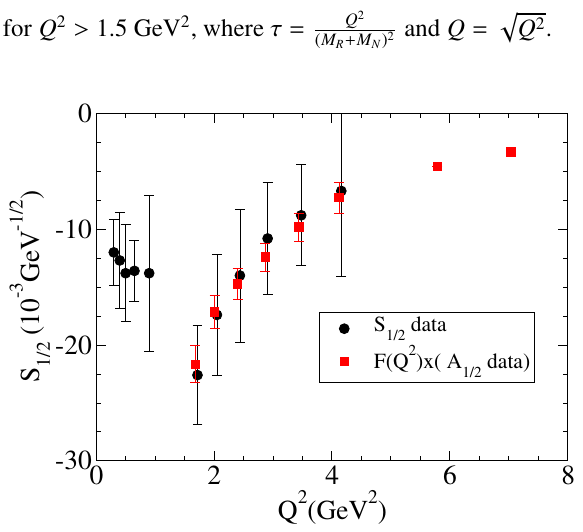
Figure 6. γ ∗ N → N (1535) amplitude S 1 / 2 . Data compared with estimate from Eq. (3). Data from CLAS [45,